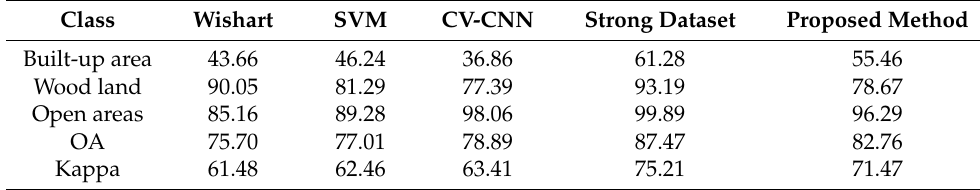
Figure 9. Classification results for the Oberpfaffenhofen dataset. ( a – d ) Classification results of the different approaches: ( a ) Wishart, ( b ) SVM, ( c ) CV-CNN, ( d ) proposed method. ( e – h ) Results overlaid with the ground-truth maps of ( a – d ), respectively. Table 3. Classification precision for the Oberpfaffenhofen dataset